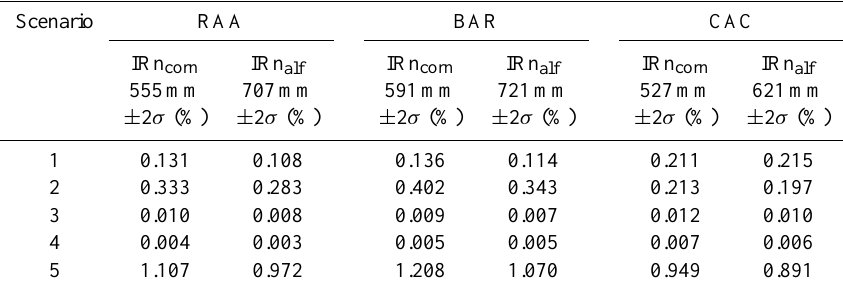
Table 6. Values of average annual net crop irrigation water requirements IRn corn and IRn alf during the period 2004–2011 with their associated error value ( ± 2 σ ) according to different scenarios (Table 3). Irrigation districts of Riegos del Alto Arag´on (RAA, Gra˜n´en weather station),